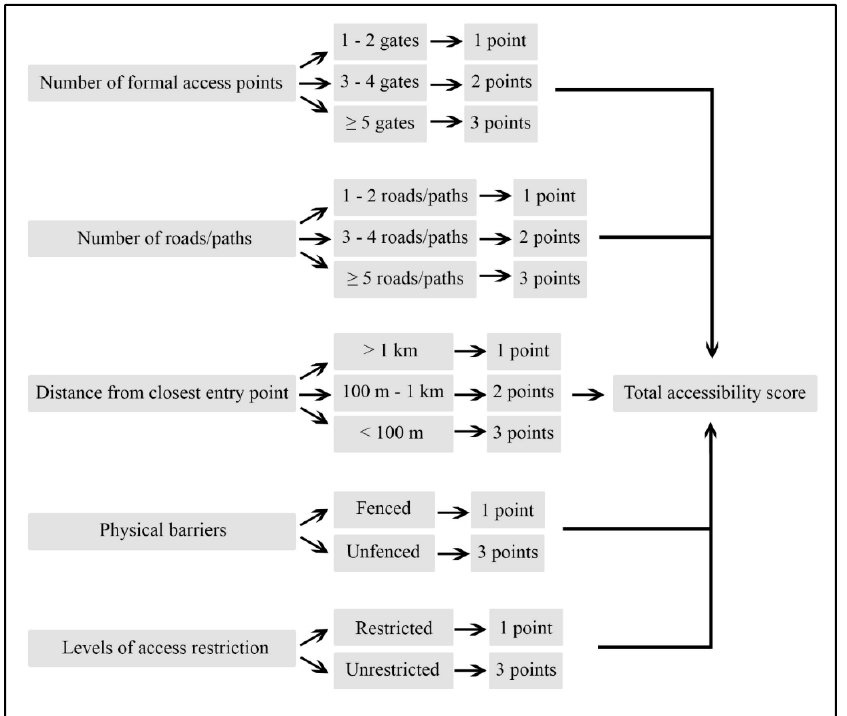
Figure A3. Flowchart highlighting how the scoring system for access points in the Table Mountain National Park was derived.